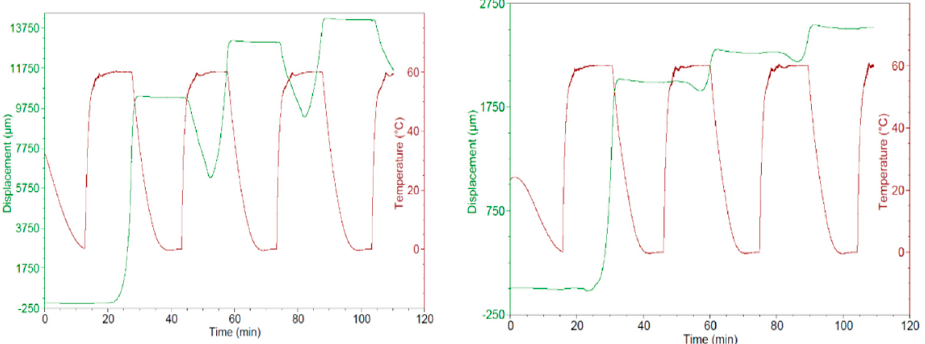
Figure 1. Behavior at the memory’s setting stage of two new